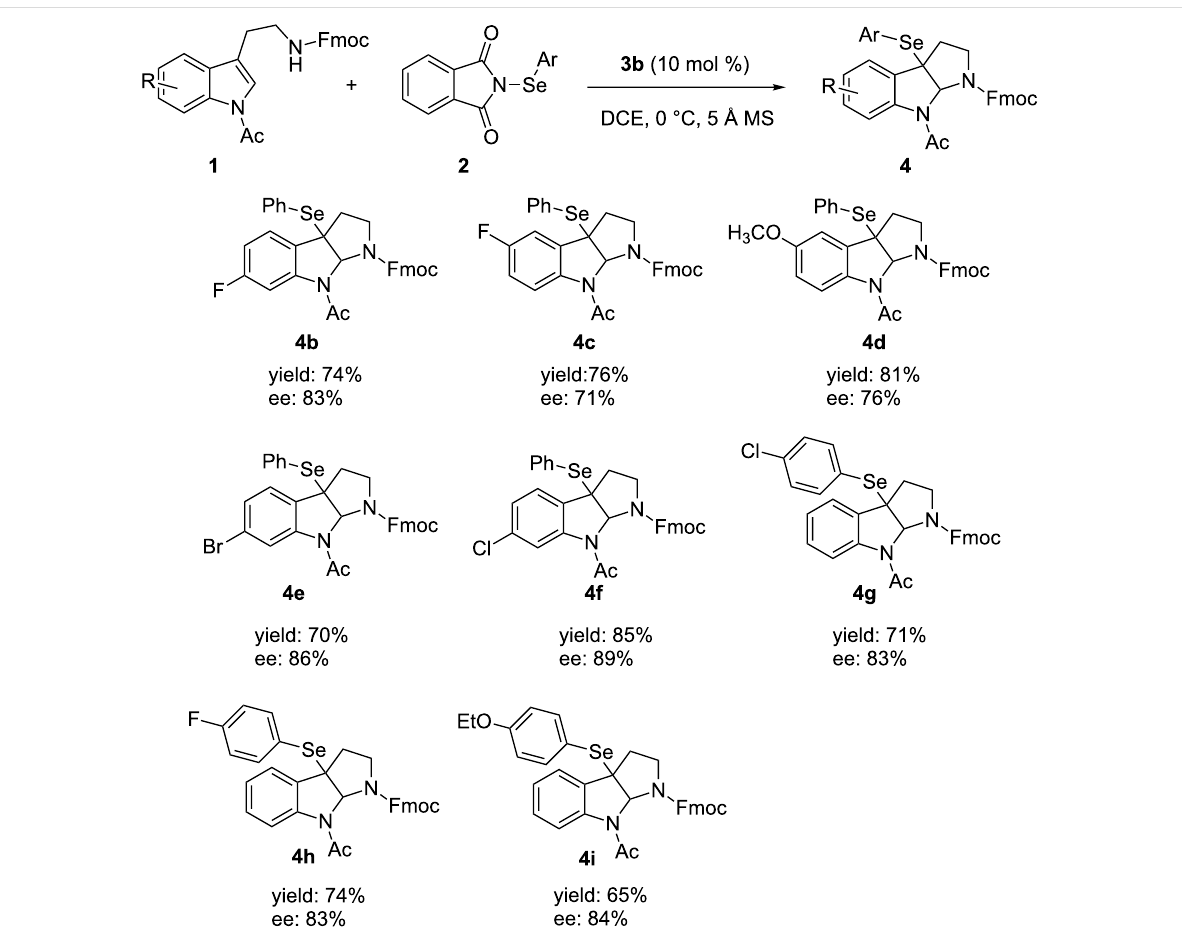
Figure 2: Generality for substitution at the indoline moiety. The reaction was performed in 0.1 mmol scale in DCE (1 mL) with 5 Å MS (100 mg) in 0 °C and the ratio of 2 / 1 is 3:1. The reaction was performed for 1–3 days. The given yields are isolated yields, and the ee’s were determined by HPLC.